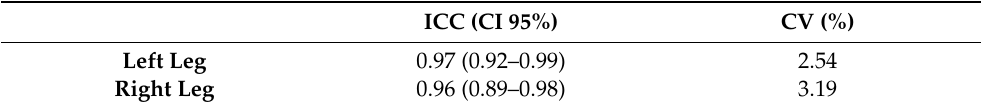
Table 2. Absolute and relative reliability.